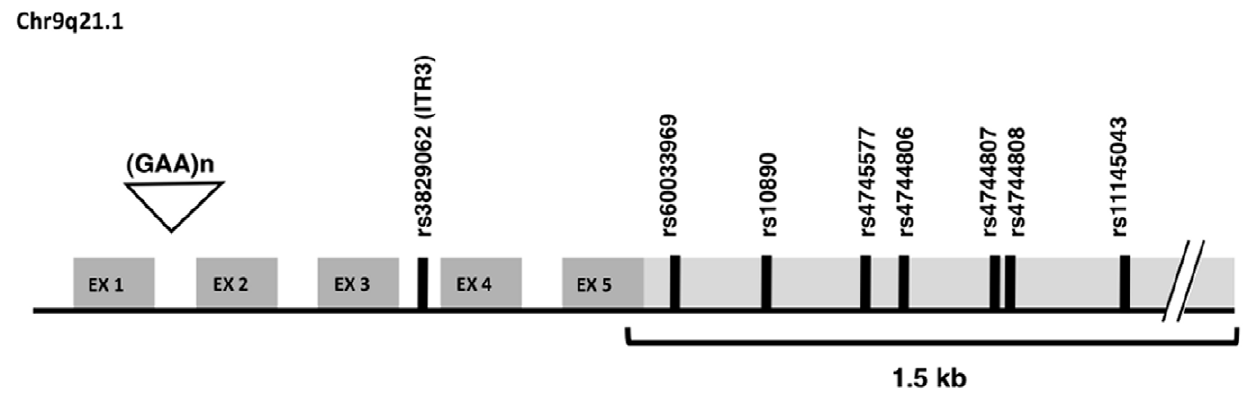
Figure 1. Schematized representation of the genomic structure of the FXN gene. The pathogenic expansion of the GAA repeat within intron 1 is indicated by a triangle, exons by grey boxes, respectively dark when translated and light when untranslated. Short genetic variations are indicated as black bars. The FXN 3 9 -UTR region, which was sequenced is highlighted by a square bracket.